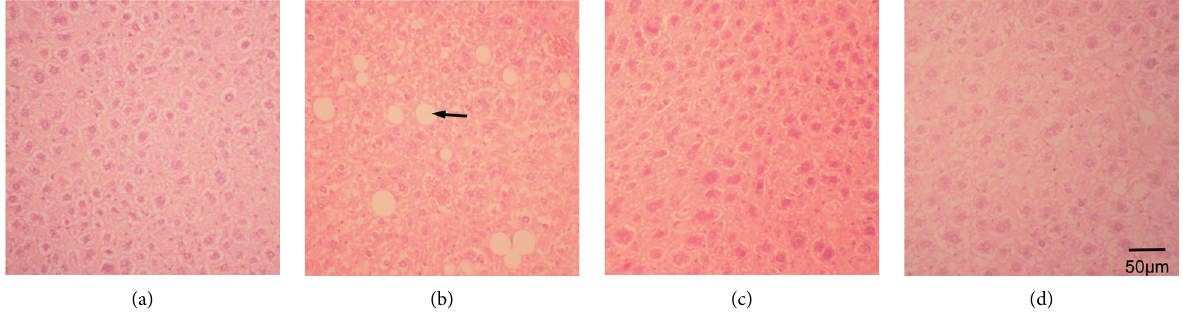
Figure 3: H&E stain of the saline- (a), ethanol- (b), fluoxetine- (c), and atorvastatin-treated (d) liver. The arrow denotes one of the lipid vesicles in fatty degeneration in the ethanol-treated liver (b), 200X.